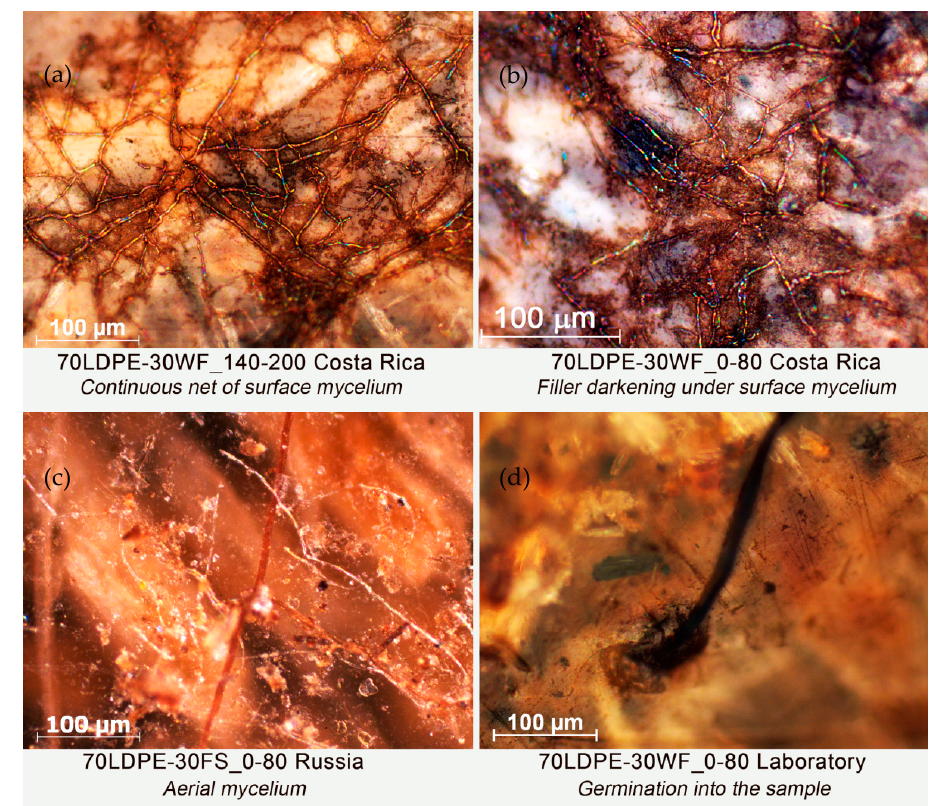
Figure 3. Microphotographs of ( a ) 70LDPE-30WF_140-200 Costa Rica, ( b ) 70LDPE-30WF_0-80 Costa Rica, ( c ) 70LDPE-30FS_0-80 Russia, and ( d ) 70LDPE-30WF_0-80 laboratory samples after biodegradation test. Reflected light, magnification 200×.